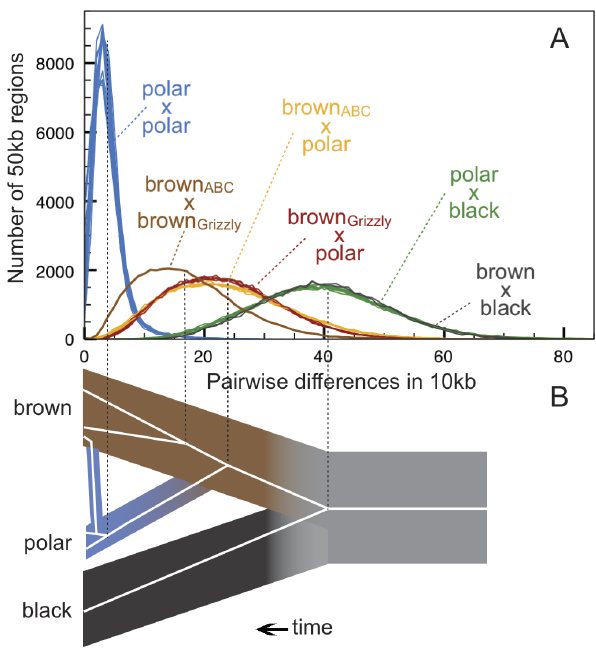
Figure 2. Genetic diversity within and between bear species. (A) Pairwise differences between individuals estimated as the average number of differences per 10 thousand bases (kb) in 42,000 non- overlapping 50 kb regions. After strict quality filtering, within-sample heterozygosity was resolved by selecting a single, high-quality base at random. The Lancaster Sound polar bear showed an excess of postmortem damage, as expected for historic specimens [32], and is shown in Figure S1. Polar bears are remarkably homogenous compared to brown bears, and both polar bears and brown bears are approximately equally diverged from the American black bear. Consistent with the results of the D- statistic test, pairwise distance between the ABC Islands brown bear and all polar bears (yellow lines) is less than that between the mainland brown bear and all polar bears (red lines). (B) Schematic diagram of a representative gene tree within brown bear, polar bear, and black bear populations, with the present day at the left of the diagram. For this locus, admixture occurring more recently than the population divergence of polar bears leads to the introgression of a polar bear haplotype into brown bears. Estimate of average genomic distance for brown, black, and polar bears and for population divergence between brown bears and polar bears given different calibration points are provided in Table 1.